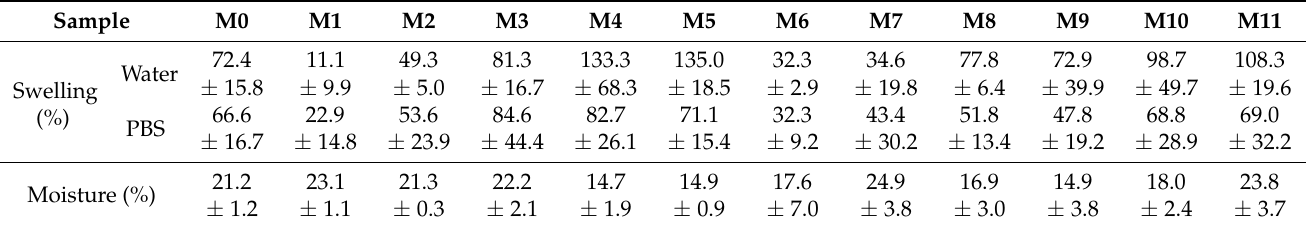
Table 4. Percentage of swelling in water and PBS solution of pH 7.2 after the period of 24 h and percentage of moisture of the synthesized membranes.